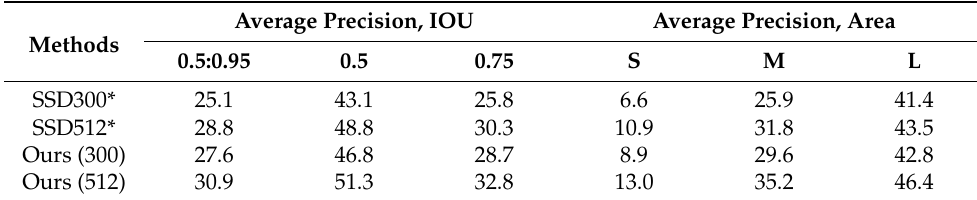
Table 3. Results on MS COCO